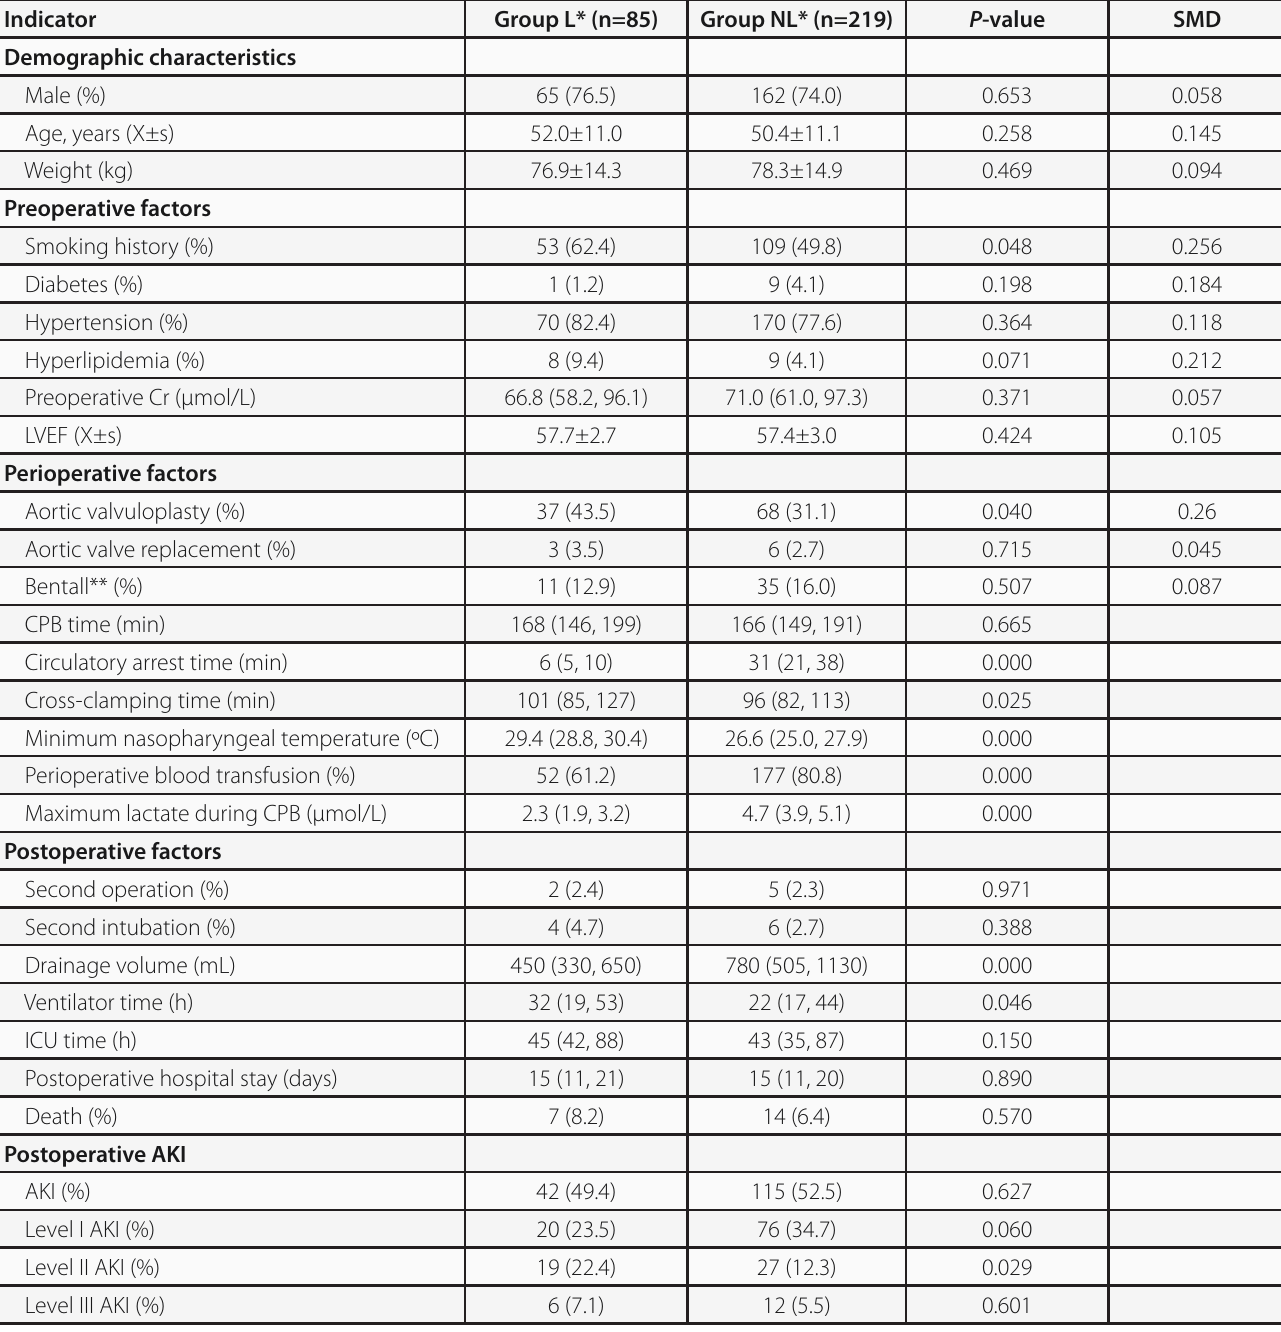
Table 2. Comparison of perioperative influencing factors before matching.